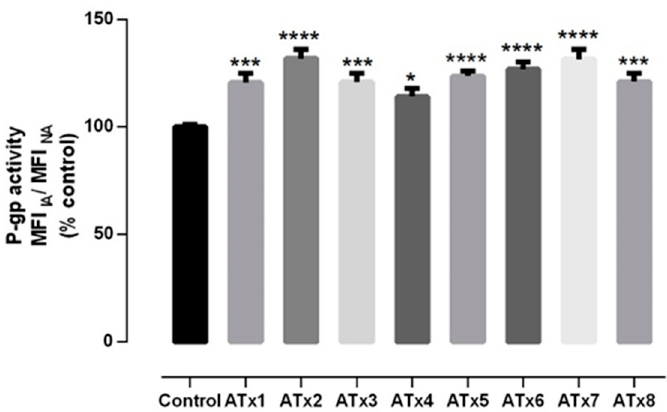
Figure 5. P-gp activity evaluated through the RHO 123 accumulation in the presence of chiral ATxs 1 – 8 (20 μ M) during the RHO 123 accumulation phase. Results are presented as mean ± SEM from five independent experiments (performed in triplicate). Statistical comparisons were estimated using One-way ANOVA, followed by Tukey’s multiple comparisons test (* p < 0.05; *** p < 0.001; **** p < 0.0001 vs. control (0 μ M)).